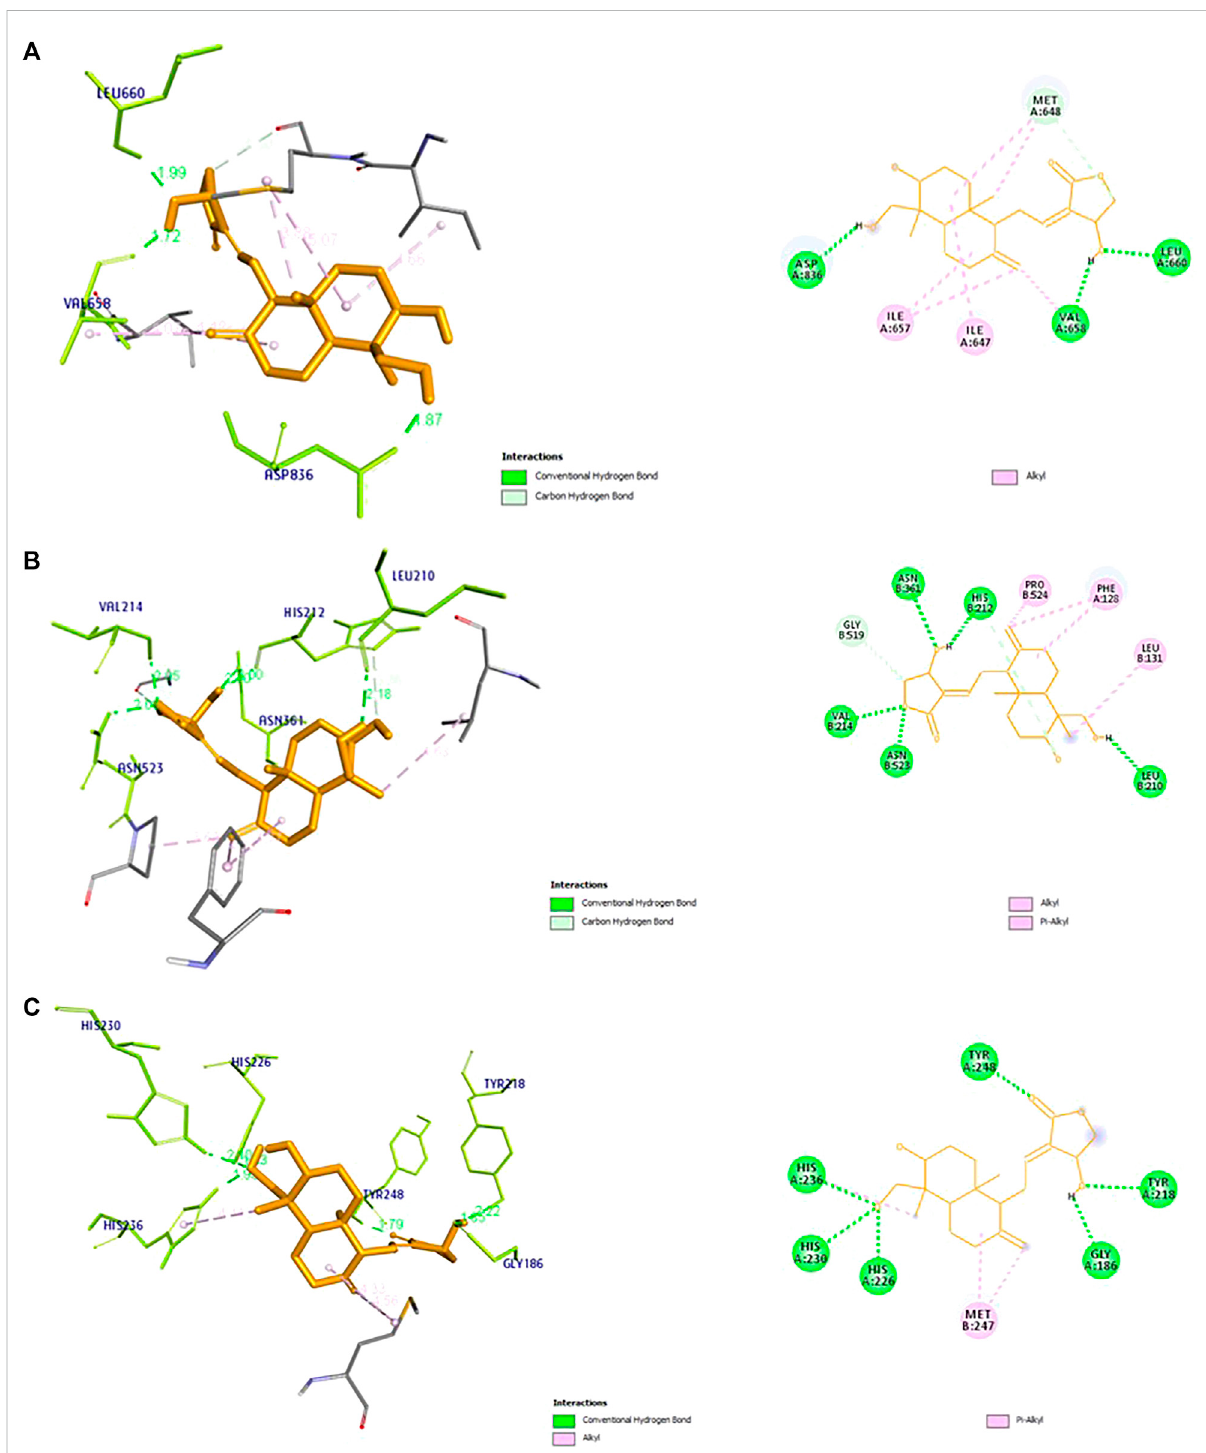
FIGURE 6 3D and 2D receptor ligand interaction diagram of top three genes with Lowest binding energy for (A) PDGFRA, (B) PTGS2, and (C) MMP9. The diagram represents the information including, type of bond between the receptor and ligand, and their bond distance.